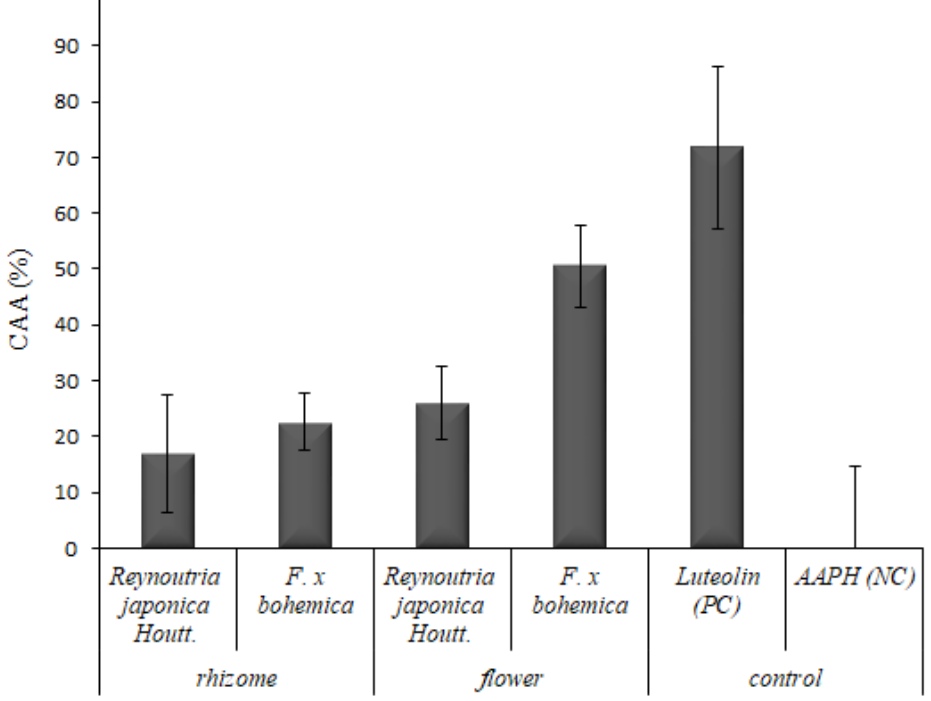
Figure 3. Cellular antioxidant activity (CAA) of knotweed extracts (γ = 0.001 mg/mL). Luteolin was used as a positive control (PC) and 2,2′ -azobis(2-amidinopropane) dihydrochloride (AAPH) as a negative control (NC). Data are presented as the average of five repetitions with the standard